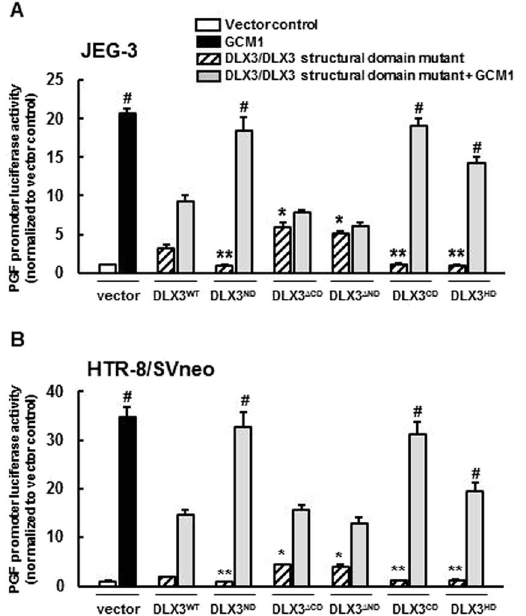
Figure 6. The DLX3 ND and CD facilitate the DLX3-GCM1 functional interaction. The PGF promoter luciferase reporter assays were performed in JEG-3 ( A ) and HTR-8/SVneo cells ( B ) to confirm the transactivation activities and GCM1-inhibitory regions of human DLX3. Cells were transfected with designated DLX3 structural domain expression plasmid (1 µ g) and pHA-GCM1 (0.5 µ g) together with PGF promoter luciferase reporter plasmid (0.2 µ g) for 48 h followed by 10 μ M MG-132 treatment for 6 h, and collected for luciferase assays. Luciferase activity is normalized to protein concentration and the vector control. Results are the mean ± standard error (SEM) of triplicates from an individual representative of three independent experiments. Asterisks denote a statistically significant difference compared with the DLX3 WT control, and # denotes a statistically significant difference compared with the combination of DLX3 WT and GCM1. * P < 0.05, ** P < 0.01, # P < 0.05 by two-way ANOVA followed by the post-hoc Bonferroni